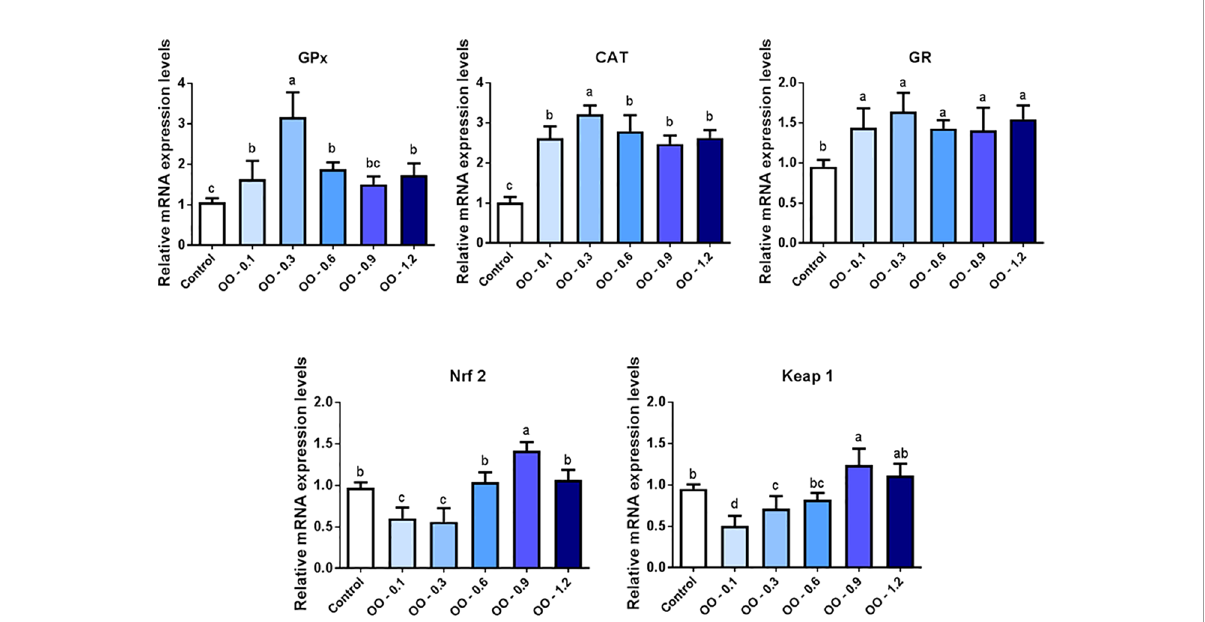
FIGURE 4 Effect of dietary oregano oil (OO) on the relative expression of antioxidant genes in the intestine of hybrid grouper. Different lowercase letters show signi fi cant differences among treatments by Tukey ’ s test (P <